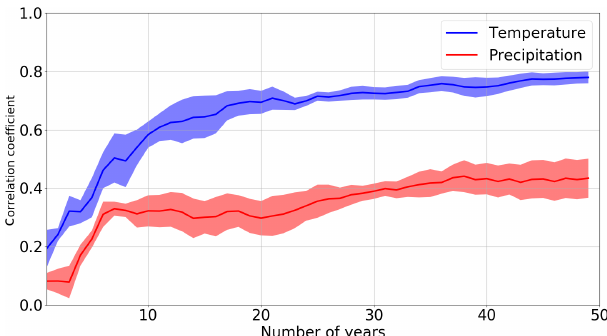
Figure 5. Correlation coefficient of temperature (precipitation) re- sponse as a function of the number of averaged years. Blue (red) is the correlation between the temperature responses to MACv2-SP aerosols in the two models. The shaded area shows the variation be- tween different control runs. The same number of years is used for the CTRL run and MACSP